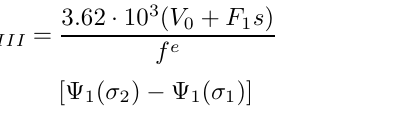
Fig. 6. The relationship between : 1 – impact energy, 2 – fre- quency, 3 – impact power and the piston displacement (piston mass m = 0 . 5 kg, piston diameter D = 4 · 10 − 2 m, air pressure in the main tube p m = 10